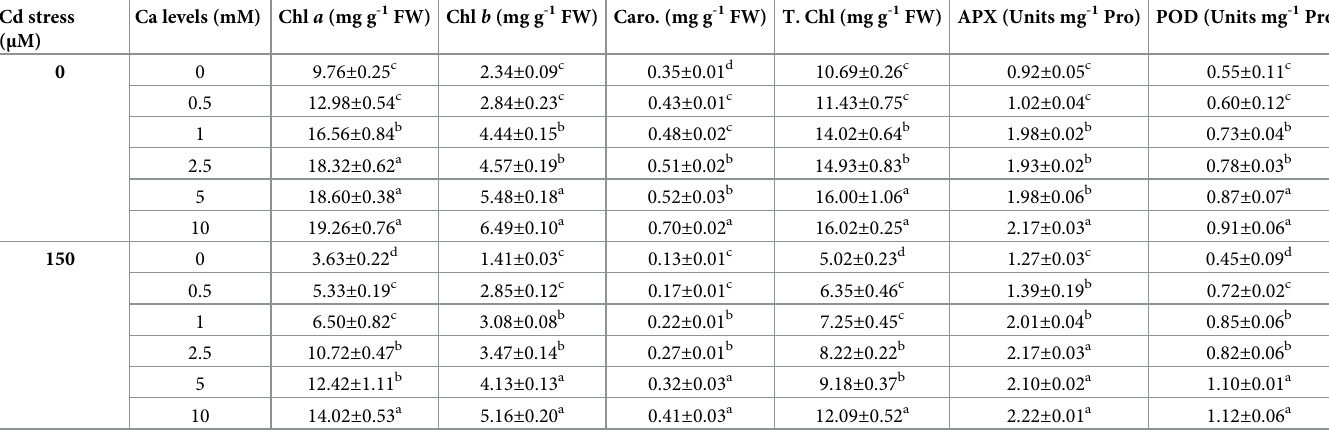
Table 2. Physiological traits of maize seedlings under various levels of Ca and Cd